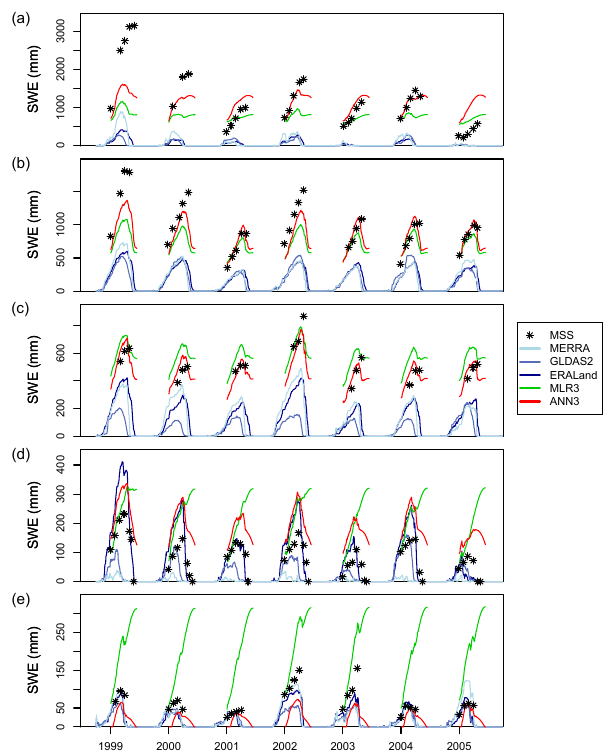
Figure 3. SWE time series for manual snow survey stations, the best three gridded SWE products, MLR3, and ANN3. Gridded products are ordered by increasing overall performance, with darker blues for better-performing products. MLR3 and ANN3 estimates are masked outside the mean first and final survey dates (2 January and 15 June respectively). A representative station is shown for each of the five physiographic regions of BC: (a) station 1D08 Stave Lake in the Coast Mountains and Islands, (b) station 2A25 Kirbyville Lake in the Columbia Mountains and Southern Rockies, (c) station 4B08 Mount Cronin in the Northern and Central Plateaus and Mountains, (d) station 2F11 Isintok Lake in the Interior Plateau, and (e) station 4C05 Fort Nelson Airport in the BC